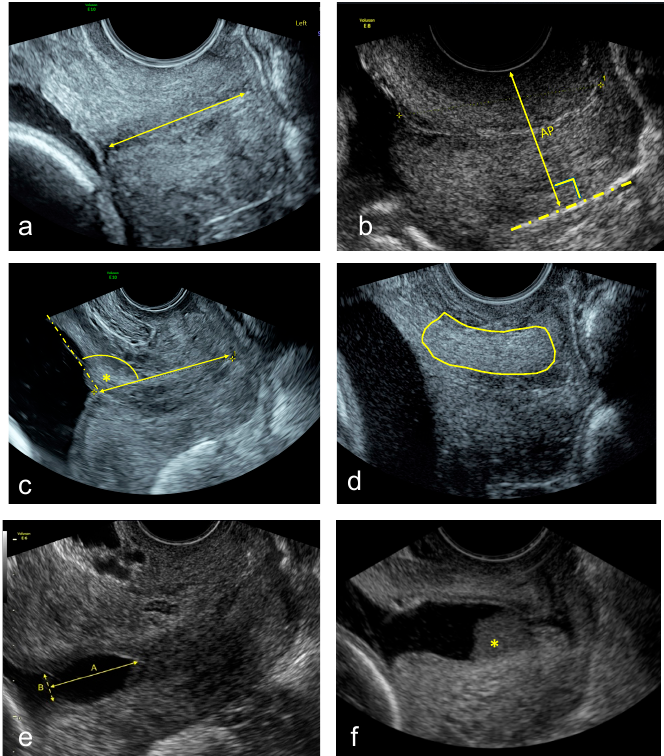
Figure 1. Example images of ( a ) Transvaginal ultrasound cervical length (straight-line) in mm. ( b ) Cervical consistency index measured as the ratio of the anteroposterior diameter with and without pressure and expressed as a percentage, CCI = (AP ′ /AP) × 100. ( c ) Utero-cervical angle calculated in degrees. ( d ) Cervical texture analysis. ( e ) Cervical funnel analysis, the longest and widest funnel at the internal os in mm. ( f ) Presence of amniotic fluid sludge (*).